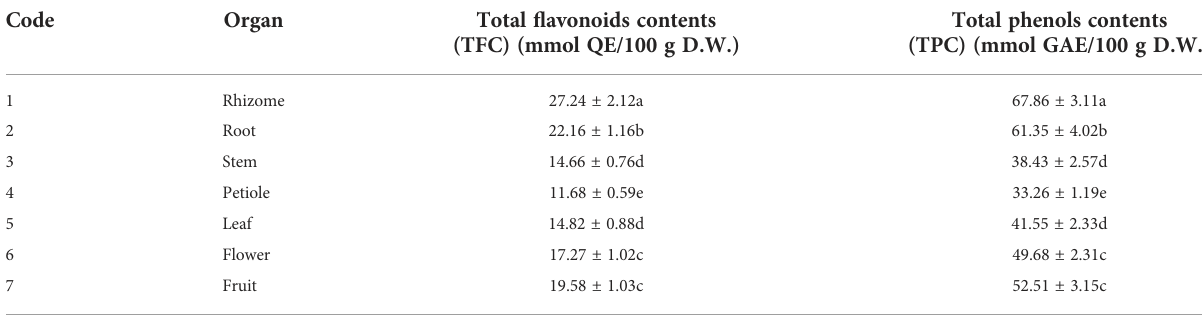
TABLE 2 Total fl avonoids contents in different organs of S. hexandrum as well as total phenols contents.